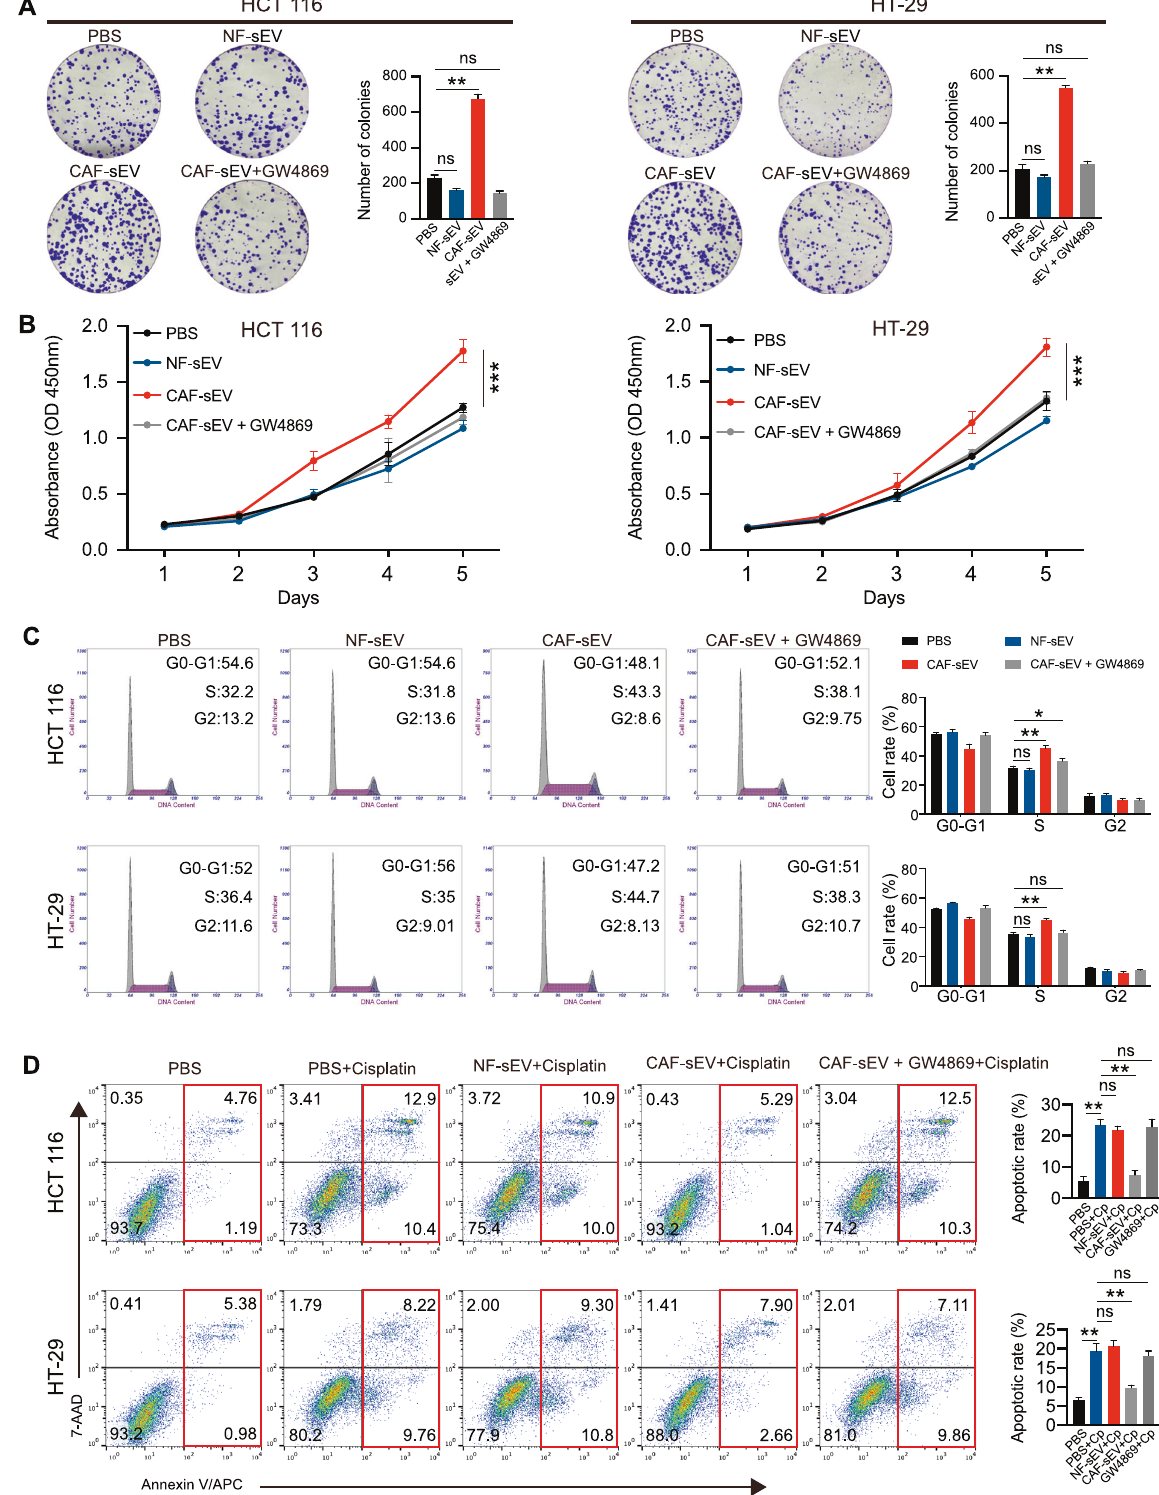
Fig. 2 CAFs-derived sEVs promote the growth of CRC cells in vitro. A Assessment of the viability of HCT 116 and HT-29 cells co-cultured with sEVs by colony formation assays. B CCK8 assays are used to determine the proliferation of CRC cells co-cultured with sEVs. C Flow cytometry shows signi fi cant increases or decreases in the proportion of cells in S or G1-phase, respectively when HCT 116 and HT-29 cells are co-cultures with CAF-sEVs. D Cells were treated with cisplatin (5ug/ml for 24 h). Flow cytometry is used to detect the apoptotic rates (LR + UR) of cells. LR, early apoptotic cells; UR, terminal apoptotic cells. Data are shown as mean ± SD of three independent experiments, * P < 0.05, ** P < 0.01, *** P < 0.001, ns. not signi fi cant.